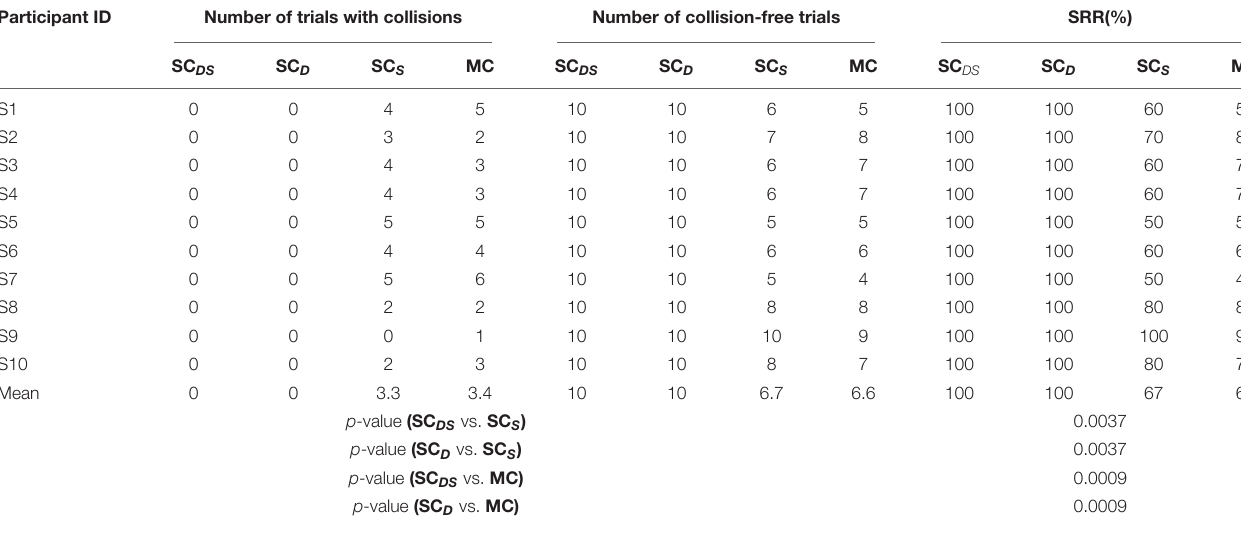
TABLE 2 | Number of trials with collisions and successful reaching rate in the experiments for the four control paradigms. Participant ID Number of trials with